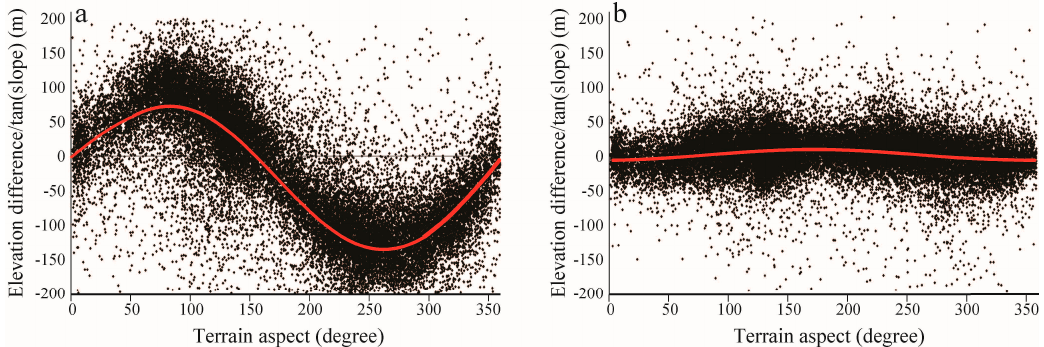
Figure 2. Scatter plot of slope-standardized altitudinal differences in the terrain aspect for off-glacier areas. ( a ) Before co-registration and ( b ) after co-registration.